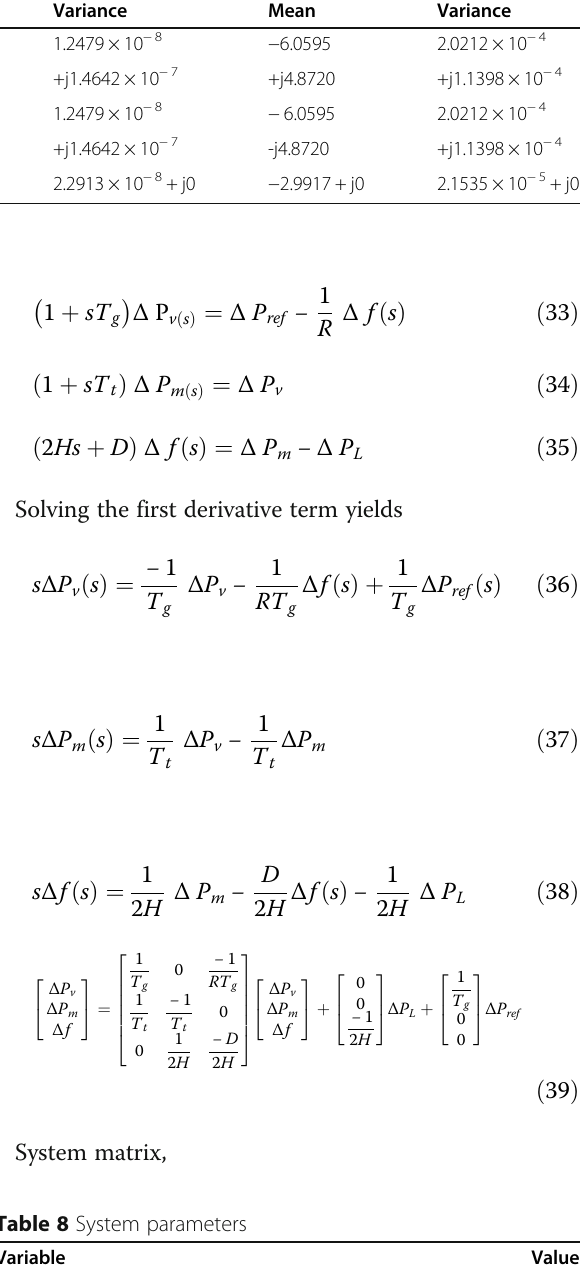
Table 6 Resulting pole placement for the feedback control Measurement noise variance= 0.005